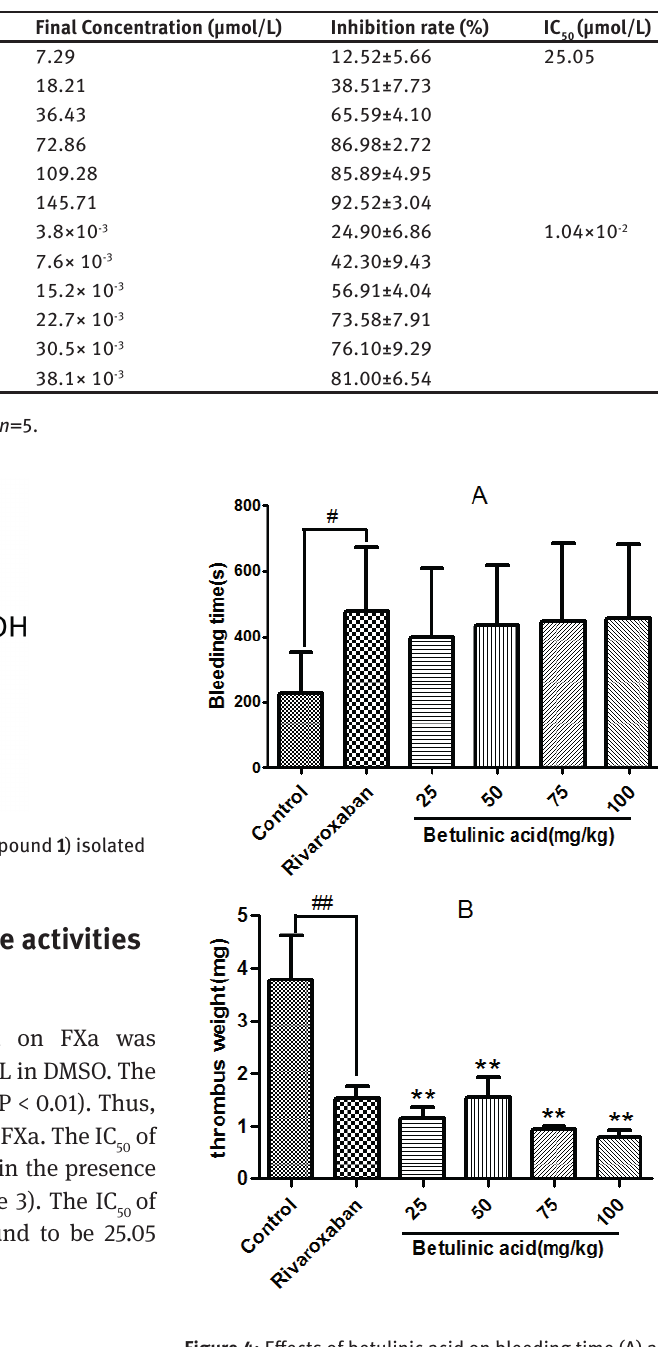
Figure 4: Effects of betulinic acid on bleeding time (A) and thrombosis of IVC (B).Values are mean±SEM ( n= 6), compared with control group ** P< 0.01, # P<